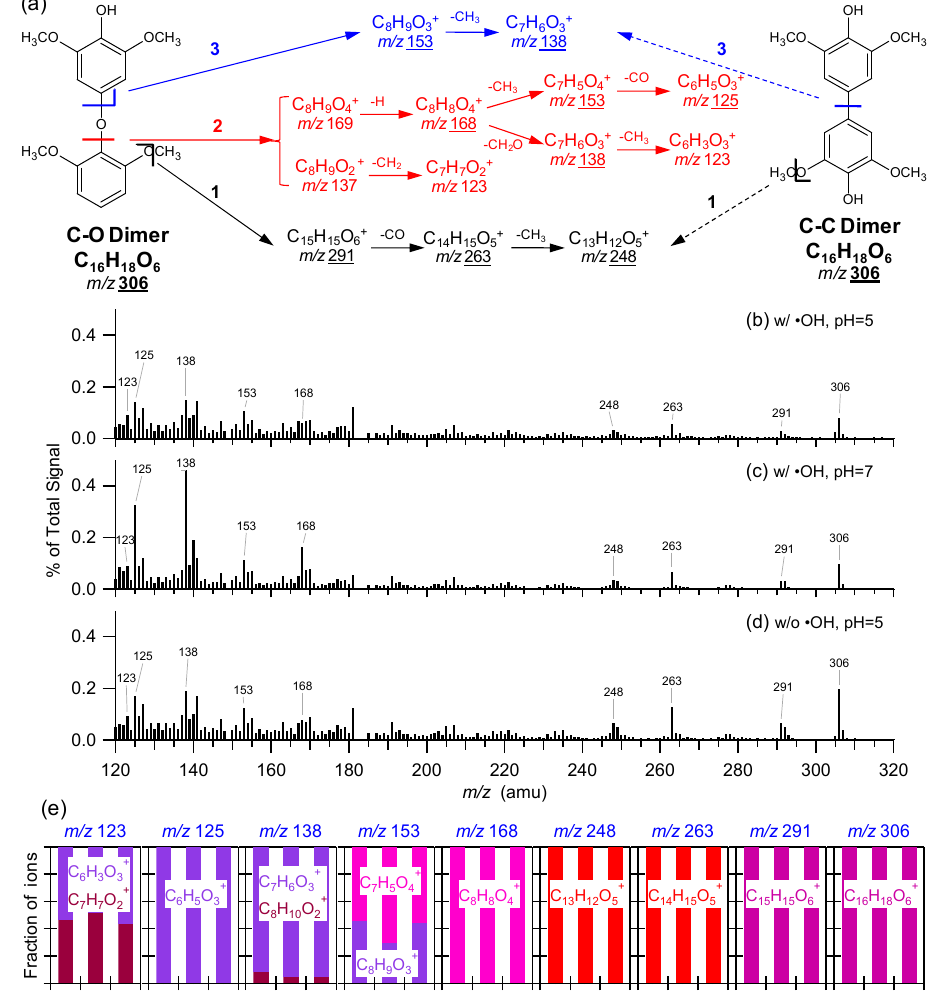
Fig. 7. (a) Postulated fragmentation mechanism and ions of syringol C-C and C-O dimers, (b–d) AMS mass spectra ( m/z 120–320) of syringol SOA produced via aqueous-phase photolysis under different experimental conditions, (e) fraction of ions for m/z ’s which are significant in (b–d) and underscored in (a). Ions containing different number of O in (e) are shown in different